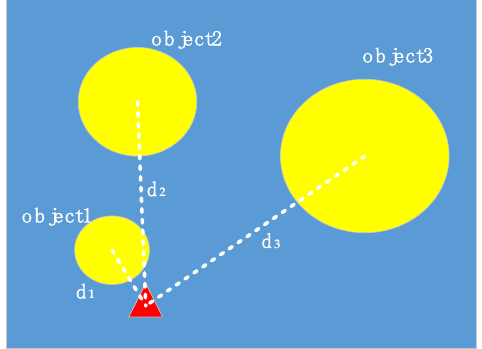
Figure 4. Distribution of objects and robots.